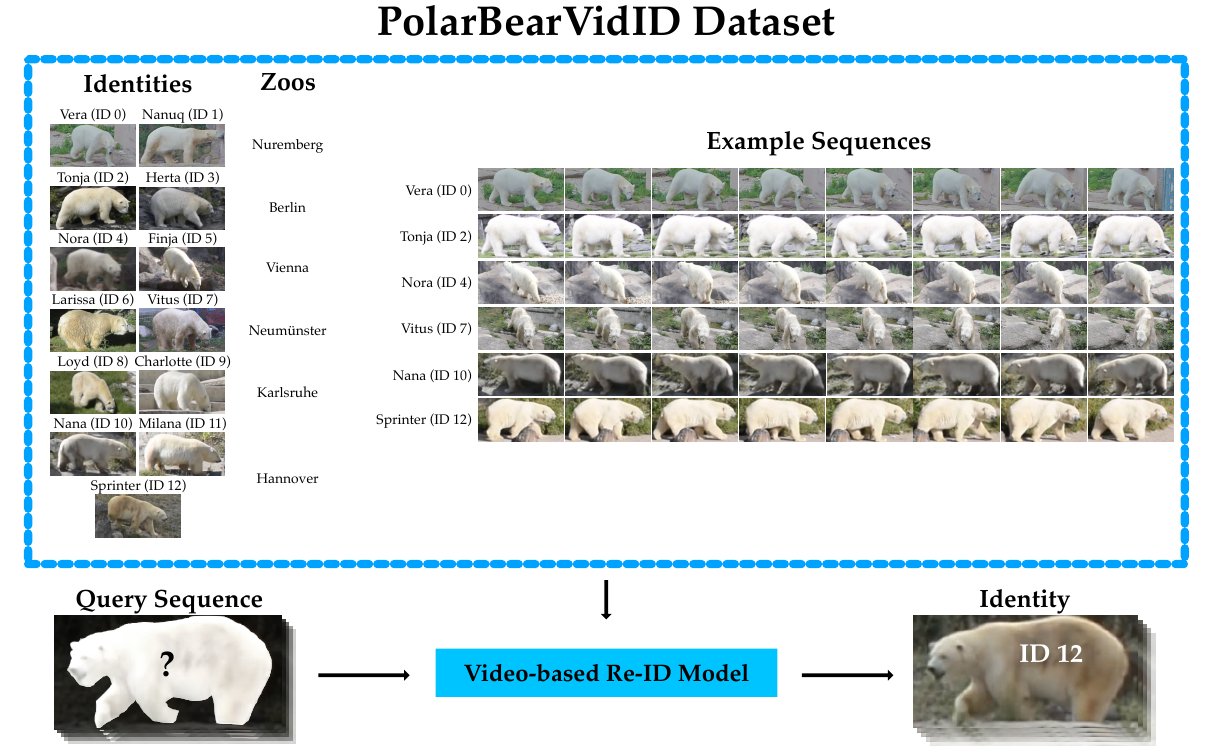
Figure 1. The PolarBearVidID dataset. It is the first dataset to date to include the movement of non-human animals to utilize this as a feature for re-ID. PolarBearVidID includes 13 individual polar bears housed in six institutions. Each identity has at least 100 sequences. The maximum length of the sequences is 8 s, respectively 100 frames at a frame rate of 12.5 frames per second. In total, the dataset includes 1431